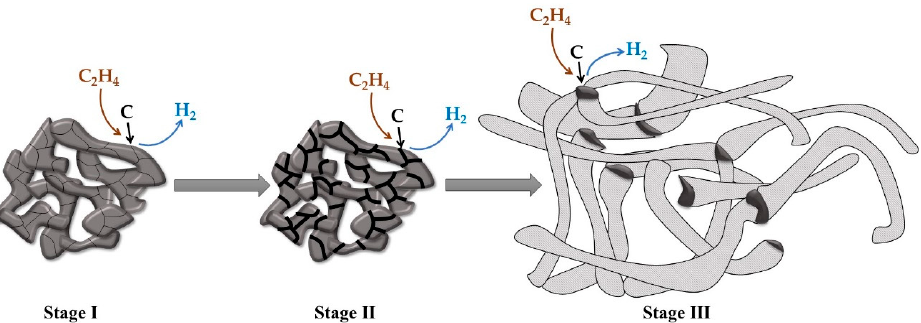
Figure 3. Schematic illustration of the CE process: (I)—catalytic decomposition of C 2 H 4 , transfer, and diffusion of carbon into the volume of the alloy; (II)—nucleation of the carbon phase at the grain boundaries; (III)—the disintegration of the alloy with the formation of active particles catalyzing the growth of CNF.